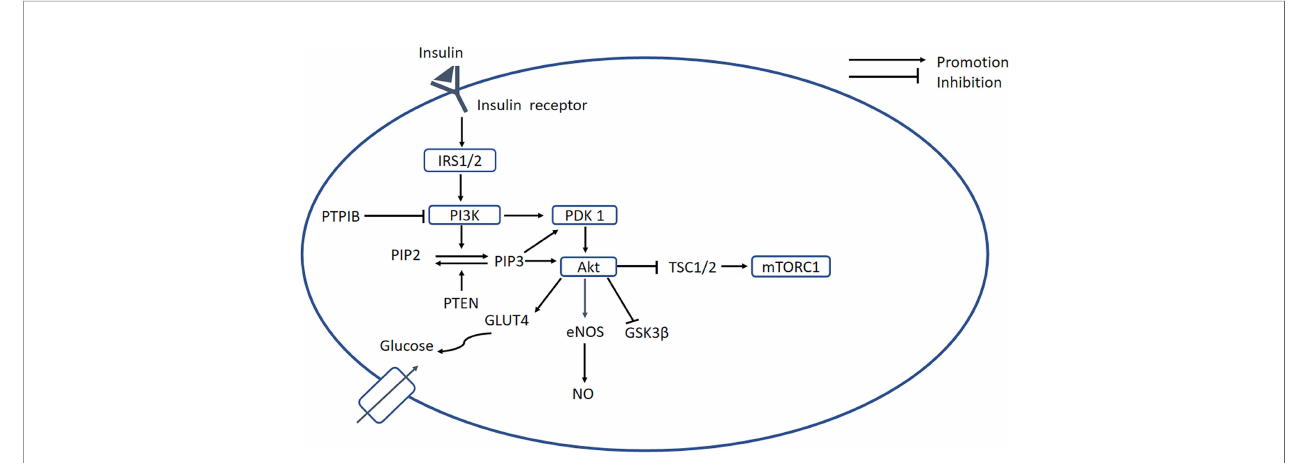
FIGURE 2 | PI3K/AKT signaling pathway. Insulin binds to its receptor, causing the recruitment of downstream signaling molecules, such as IRSs. The phosphorylation of IRS enables binding of PI3K, which phosphorylates PIP2 to form PIP3, while PTEN can dephosphorylate PIP3. A high concentration of PIP3 causes the recruitment of PDK1, which promotes activation of AKT. In turn, AKT induces glycogen storage by inhibiting GSK-3 b , and increases uptake of glucose by promoting translocation of GLUT4 vesicles. PTP1B serves as an important negative regulator of insulin signaling. In addition, AKT inhibits mTORC1 by inhibiting TSC1/2, and PI3K/AKT activates eNOS, leading to the release of NO. In DCM, the PI3K/AKT pathway is blocked, resulting in decreases in intracellular glucose transport and NO bioavailability. PI3K, phosphatidylinositol 3-kinase; PKB/AKT, protein kinase B; IRSs, insulin receptor substrates; PIP2, phosphatidylinositol 4;5- bisphosphate; PIP3, phosphatidylinositol 3;4;5-bisphosphate; PDK1, 3-phosphoinositide-dependent protein kinase 1; mTORC1, mechanistic target of rapamycin complex 1; TSC1;2, tuberous sclerosis complex 1;2; GSK-3 b , glycogen synthase kinase 3 b